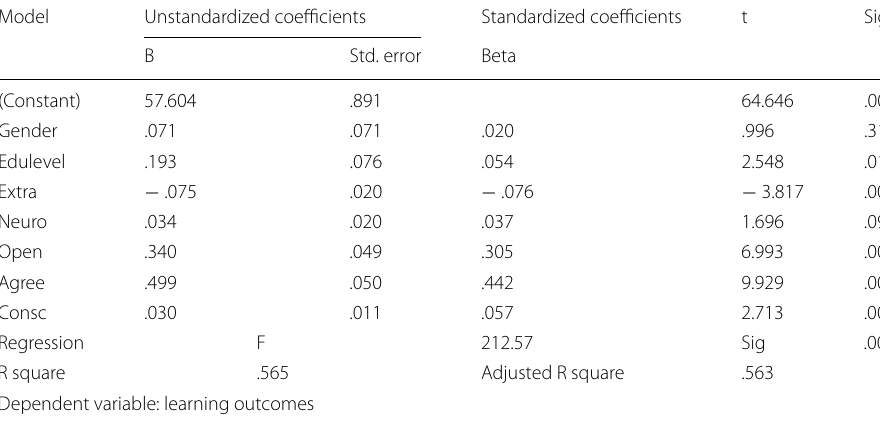
Edulevel Educational levels, Extra extraversion, Neuro neuroticism, Open openness to a new experience, Agree agreeableness, Consc conscientiousness, Outcome learning outcomes